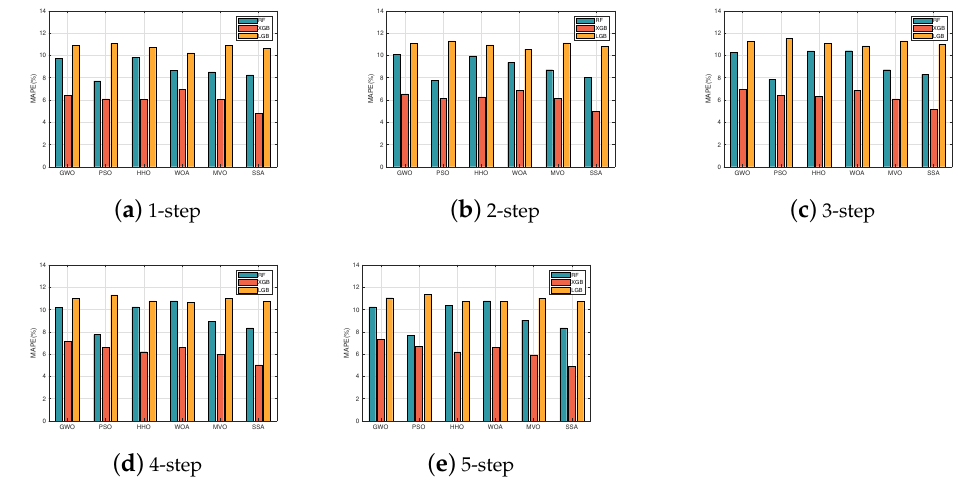
Figure 13. MAPEs of XGBoost, Random Forest and LightGBM with multi-step ahead forecasting steps for the UK NGC